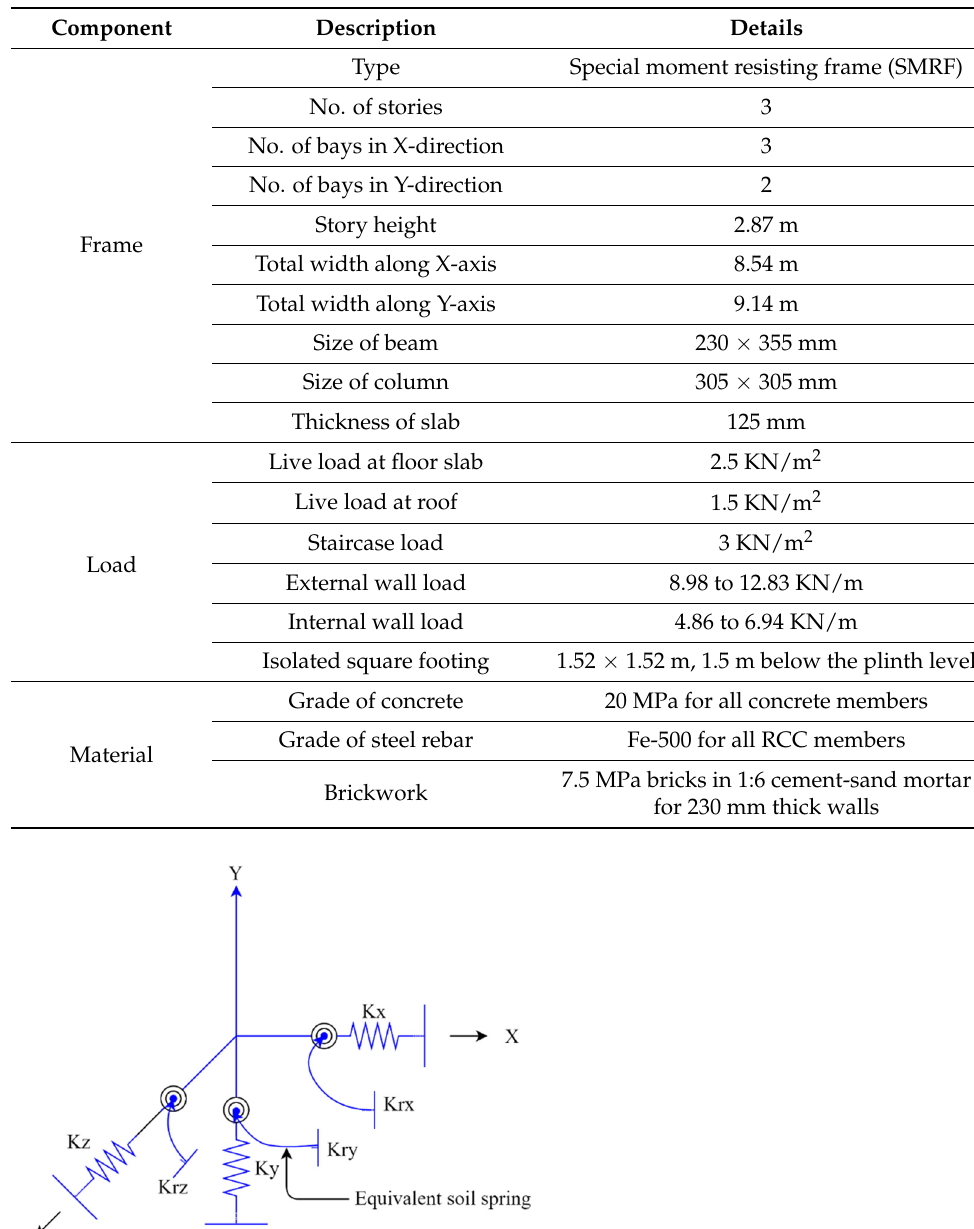
Table 1. Geometric and material properties used for finite element modeling.